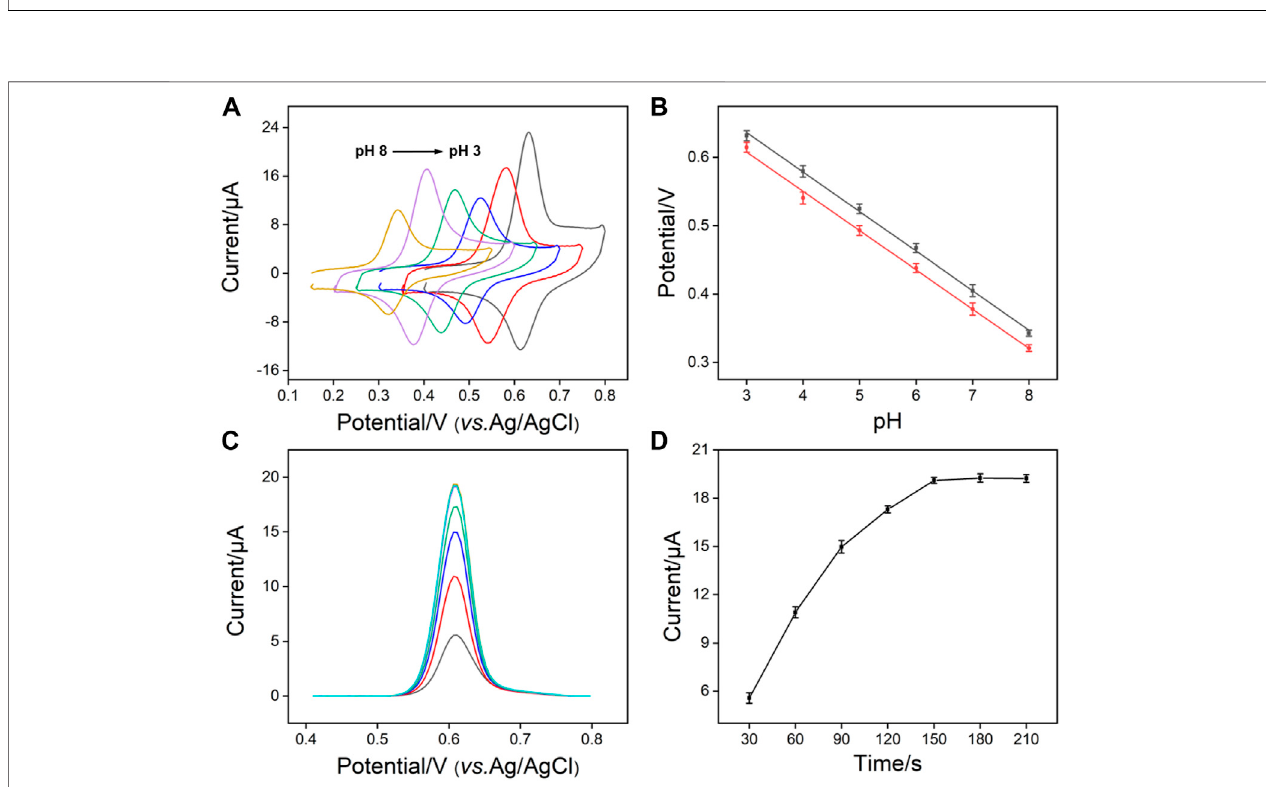
curve semicircle in high frequency region. When SM exists in